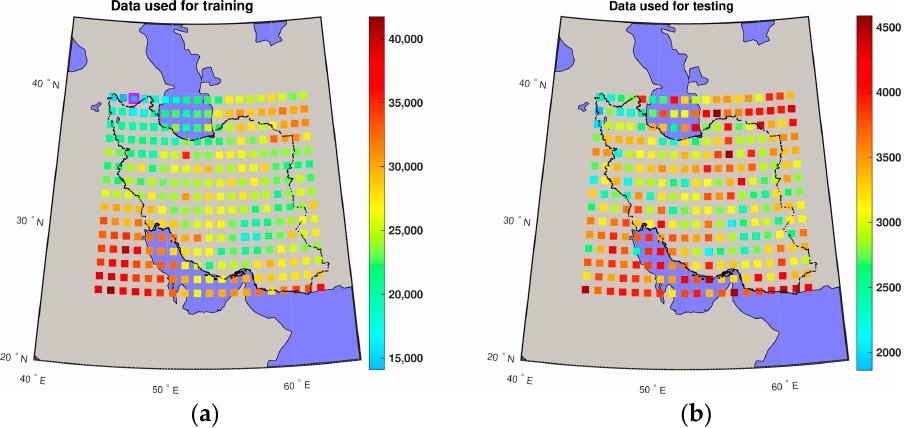
Figure 3. An overview of the number of RO observations used in 1 ◦ × 1 ◦ resolution patches for ( a ) training and ( b ) testing the ELM. The patch with the least RO observations for the training step has been shown with magenta borders around it in ( a ).